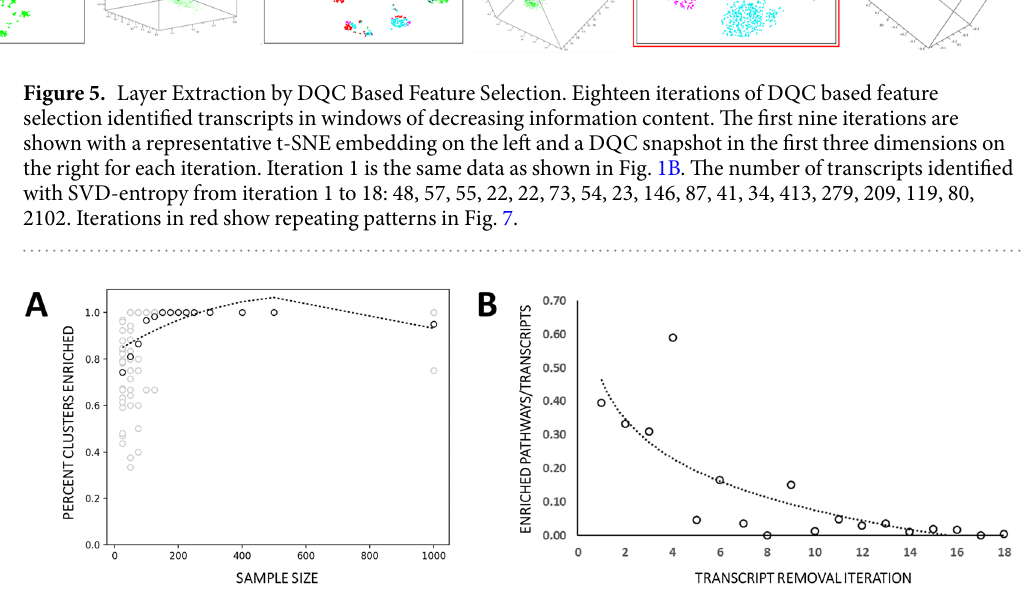
Remaining transcripts after iterative removal of important transcripts were studied by both DQC and t-SNE (iterations 1–9 shown in Fig. 5). All iterations reveal varying capacity of the remaining transcripts to segregate the